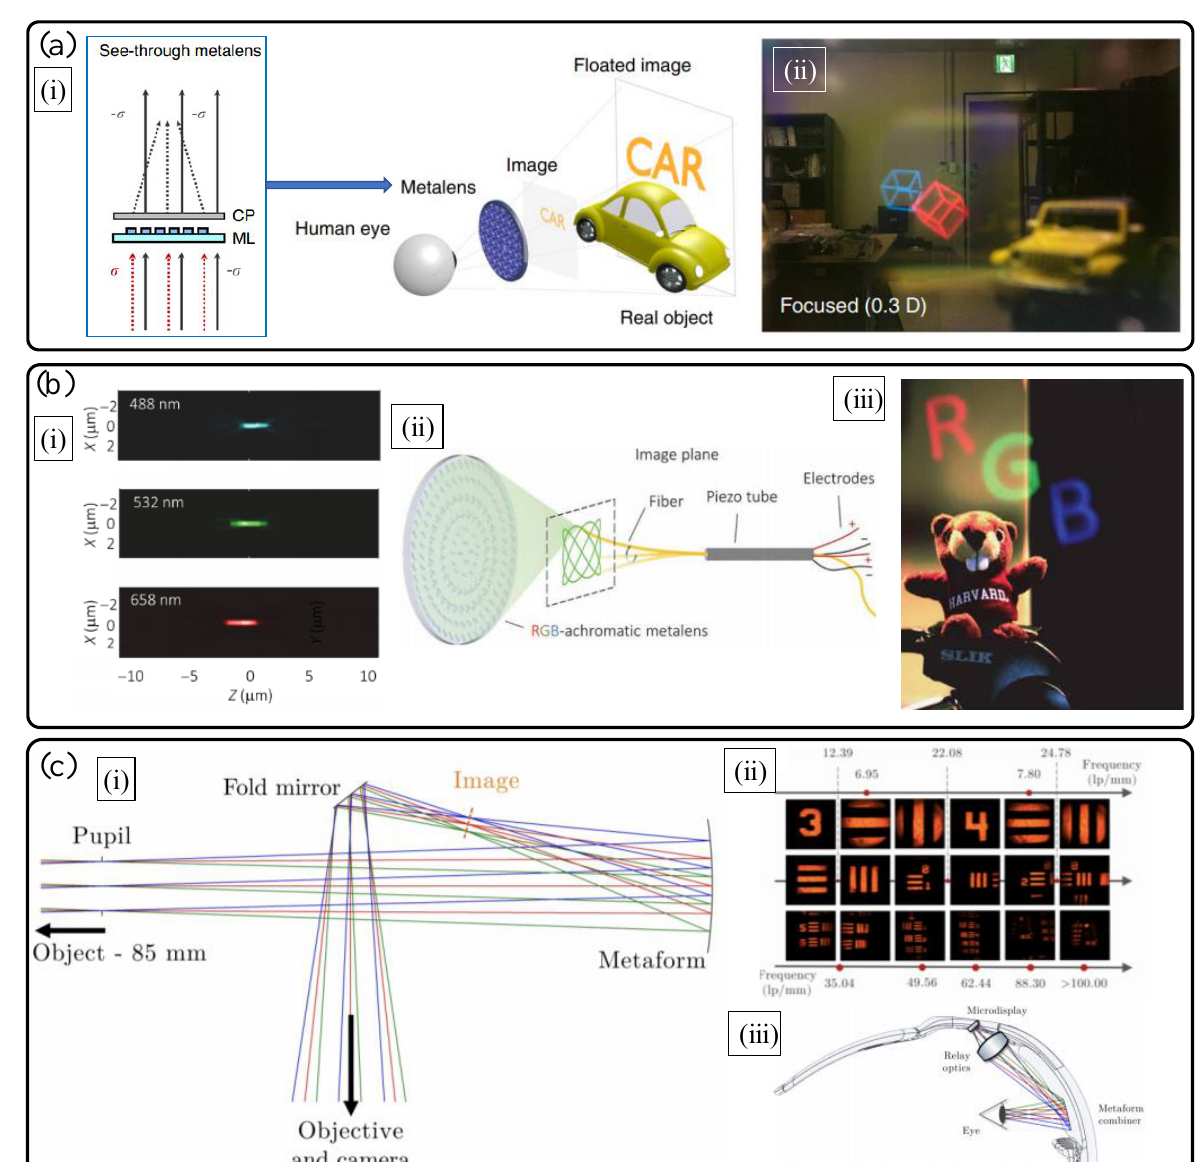
Figure 6. Metalenses for three-dimensional display applications: near-eye displays for augmented reality (AR) and virtual reality (VR). ( a ) Geometric phase based metasurface eyepiece as a see-through image combiner [28]. ( i ) Schematic diagram and ( ii ) captured full-color augmented reality scene with a camera. ( b ) Inverse designed metalens with chromatic aberration correction and its use in near-eye virtual image generation [29]. ( i ) Measured longitudinal apochromatic focusing property, ( ii ) principle of metalens assisted fiber scanning display, and ( iii ) captured image of full-color augmented reality scene using a beam splitter as an image combiner. ( c ) Hybridization of dielectric metasurface and freeform optics [30]. ( i ) Ray tracing diagram of a miniature image combiner design with a metaform mirror and ( ii ) the imaging result of a resolution target. ( iii ) A possible idea to use a metaform mirror as a see-through image combiner for a wearable near-eye display for AR curved eyeglass. ( a ) Reprinted with permission from [28] Copyright 2018 Springer Nature. Reprinted with permission from ( b ) from [29] and ( c ) from [30] Copyright 2021 The American Association for the Advancement of Science.